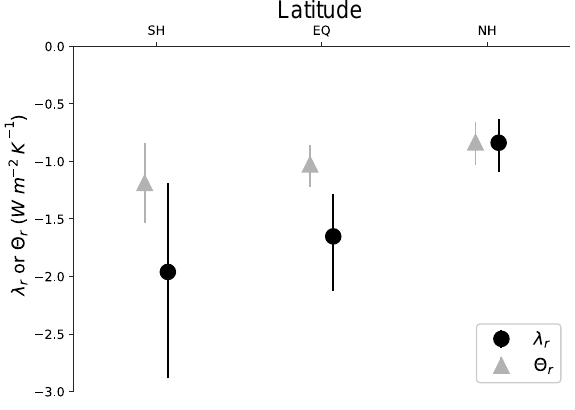
Figure 5. λ r and (cid:50) r calculated as regional average (cid:49)(R − F) di- vided by regional average temperature ( (cid:49)T S for λ and (cid:49)T A for (cid:50) ). The regions are 90–19.4 ◦ S (SH), 19.4 ◦ S–19.4 ◦ N (EQ), and 19.4– 90 ◦ N (NH). The values are calculated for each member of the 100- member ensemble; the solid symbols are the ensemble average, while the bars show the 5–95%